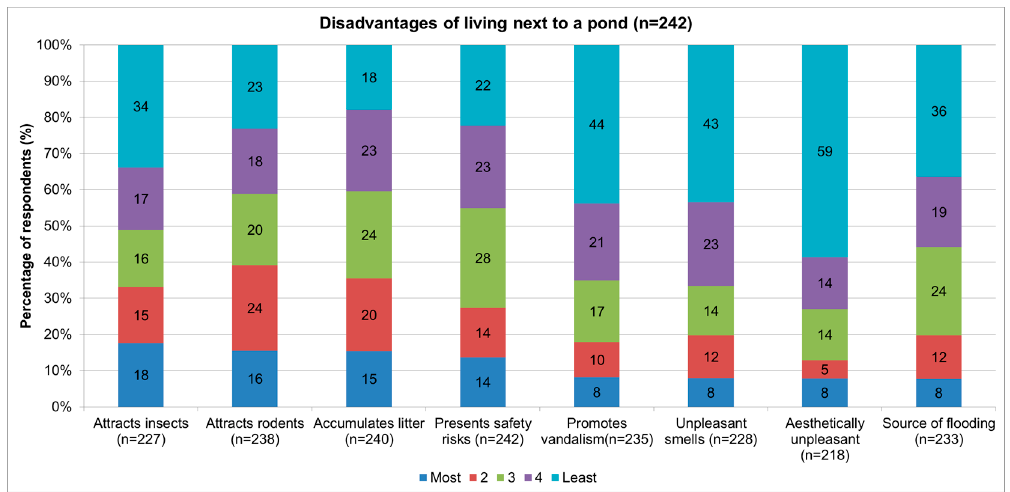
Figure 4. Disadvantages of living next to a pond (within walking distance), rated 1: Greatest disadvantage to 5: Lowest disadvantage.